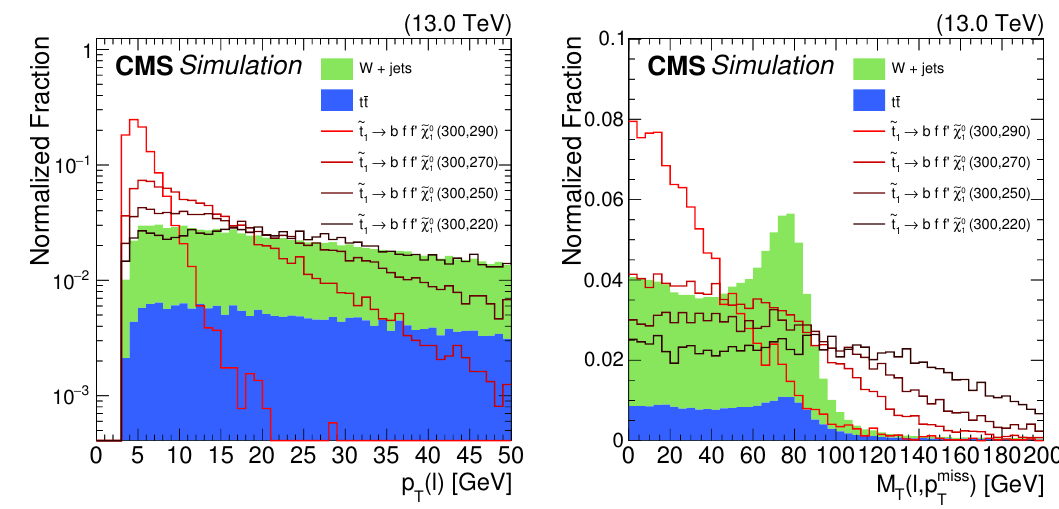
Figure 3 . Simulated distributions of p T ( ‘ ) (left) and M T (right) at the preselection level for signal samples with di(cid:11)erent (cid:1) m , and W+jets and tt background events. The area of each signal distribution, and the total background contribution, are normalized to unit